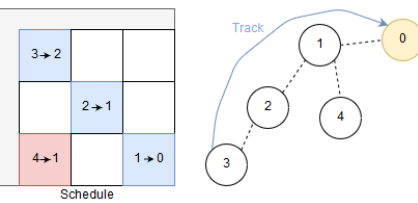
Figure 1. Illustration of a IPv6 over the TSCH mode of IEEE 802.15.4e (6TiSCH) track from 3 to